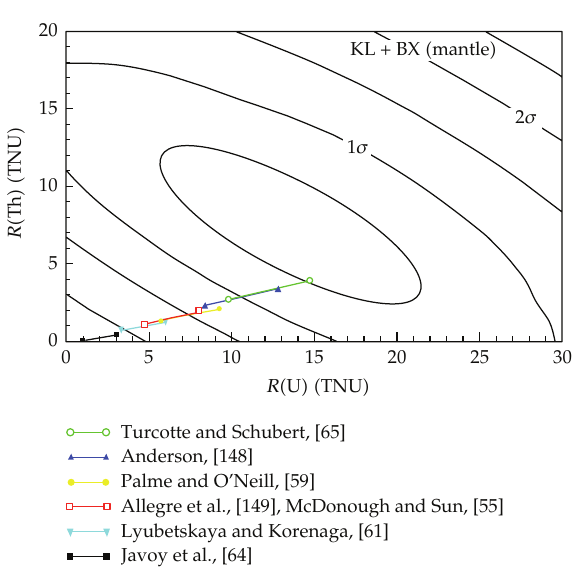
Figure 12: Experimental constraints on mantle flux from combined analysis of KamLAND and Borexino data (cid:5) black contour lines (cid:6) , compared to predictions from various BSE abundance estimates (cid:3) 55, 59, 61, 64, 65, 148, 149 (cid:4) . Adapted from (cid:3) 146 (cid:4)